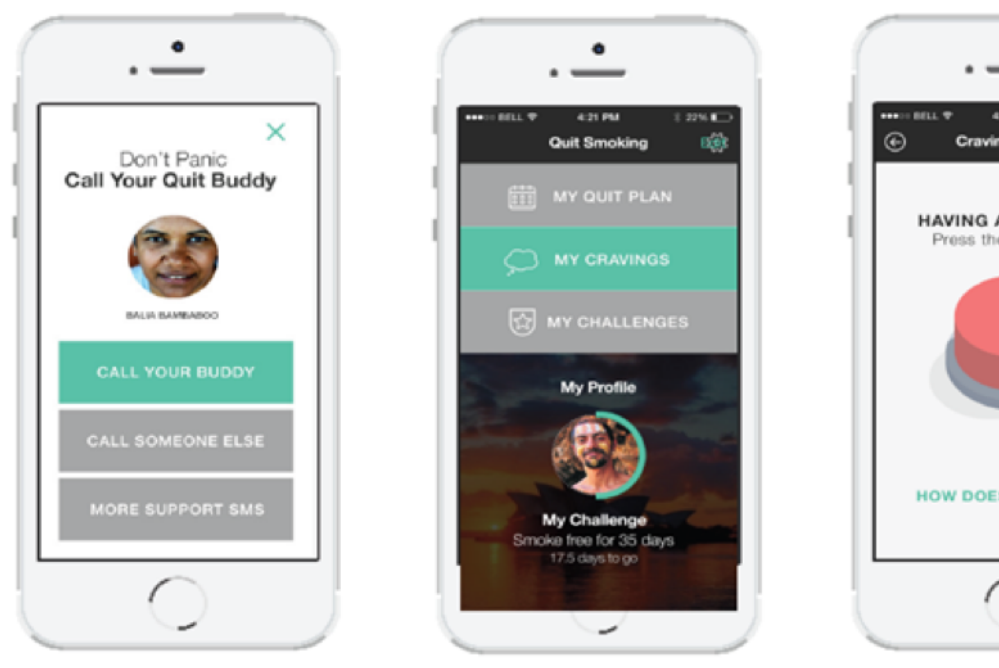
Figure 5. Manage cravings